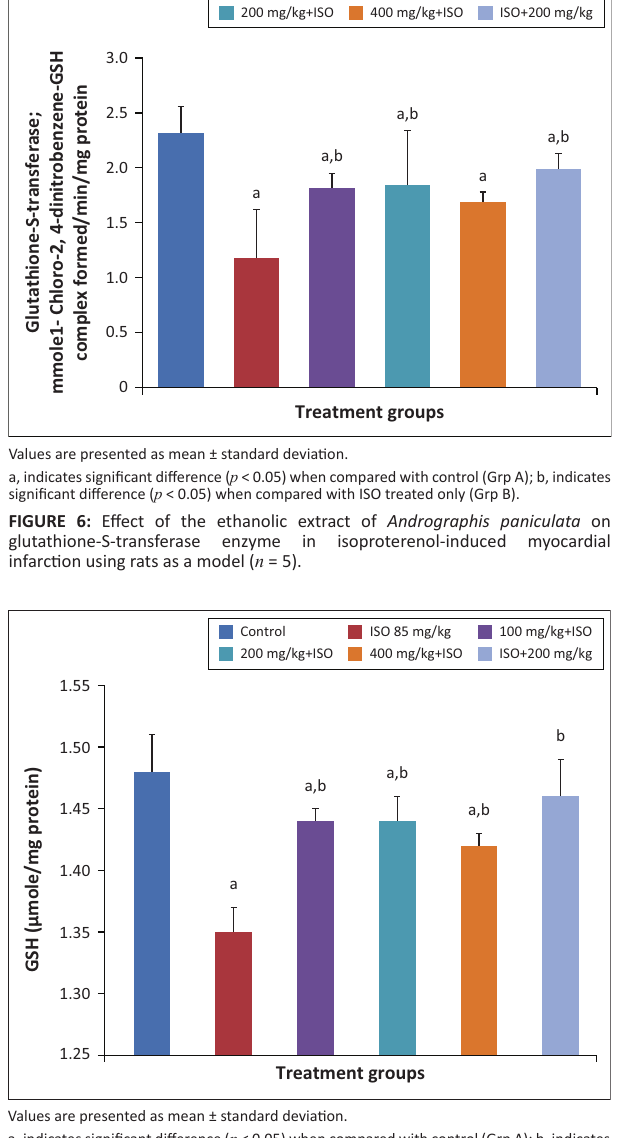
FIGURE 7: Effect of the ethanolic extract of Andrographis paniculata on reduced glutathione in isoproterenol-induced myocardial infarction using rats as a model ( n = 5). The effect of A. paniculata on reduced glutathione (GSH).